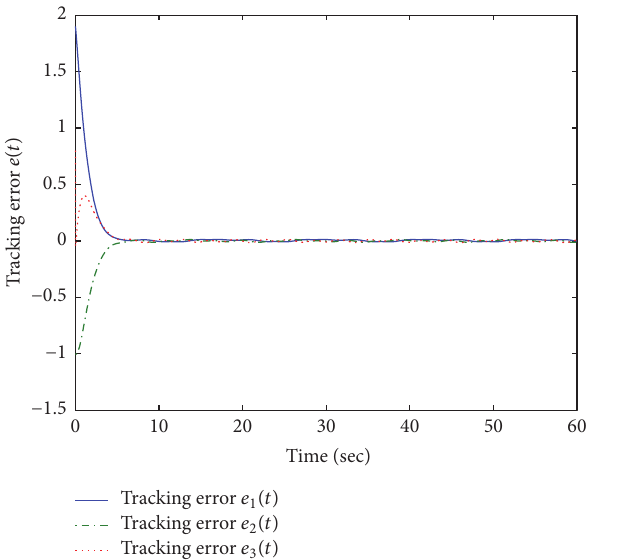
Figure1:Trajectoryofthetrackingerrors 𝑒 1 = 𝑦−𝑥 𝑑 and 𝑒 2 = ̇𝑦− ̇𝑥 𝑑 .